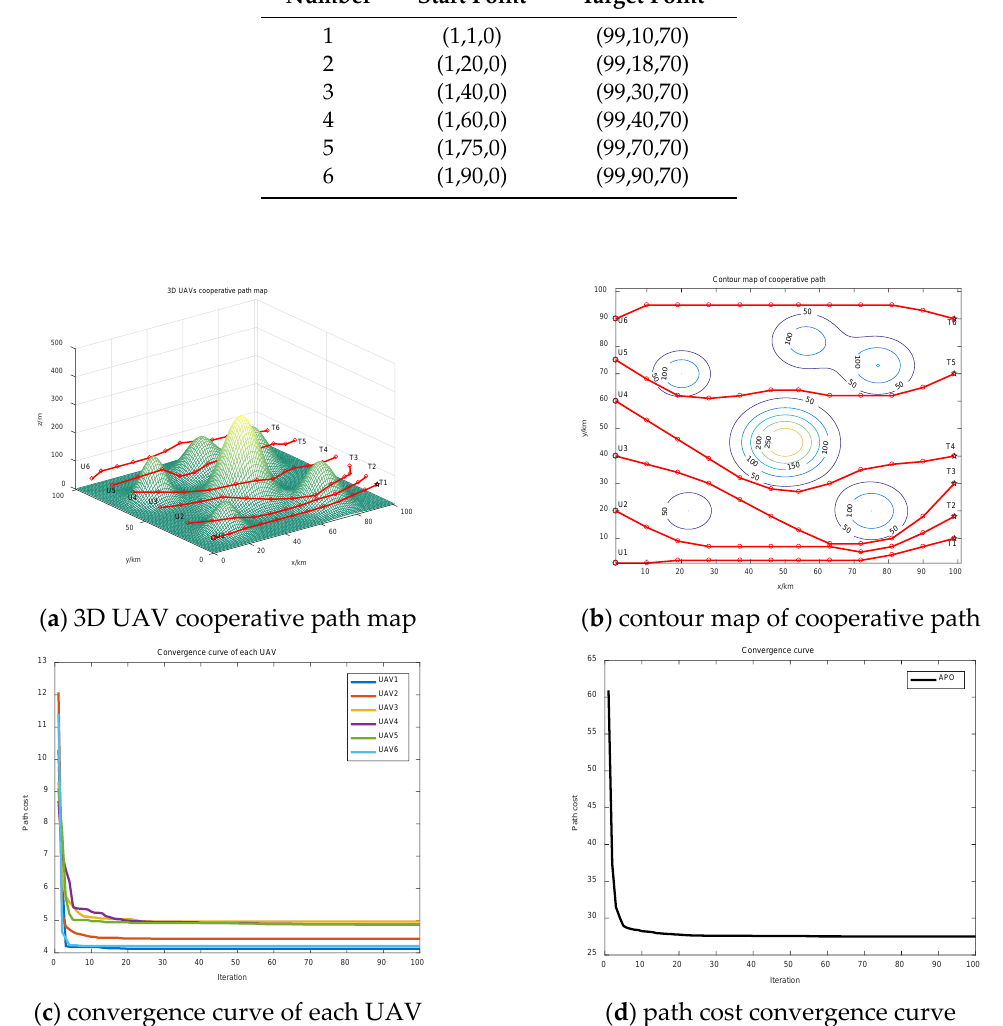
Figure 10. The result of case 3. ( a ) 3D UAV cooperative path map; ( b ) contour map of cooperative path; ( c ) convergence curve of each UAV; ( d ) path cost convergence curve. Table 14. Range and flight time of each aircraft (case